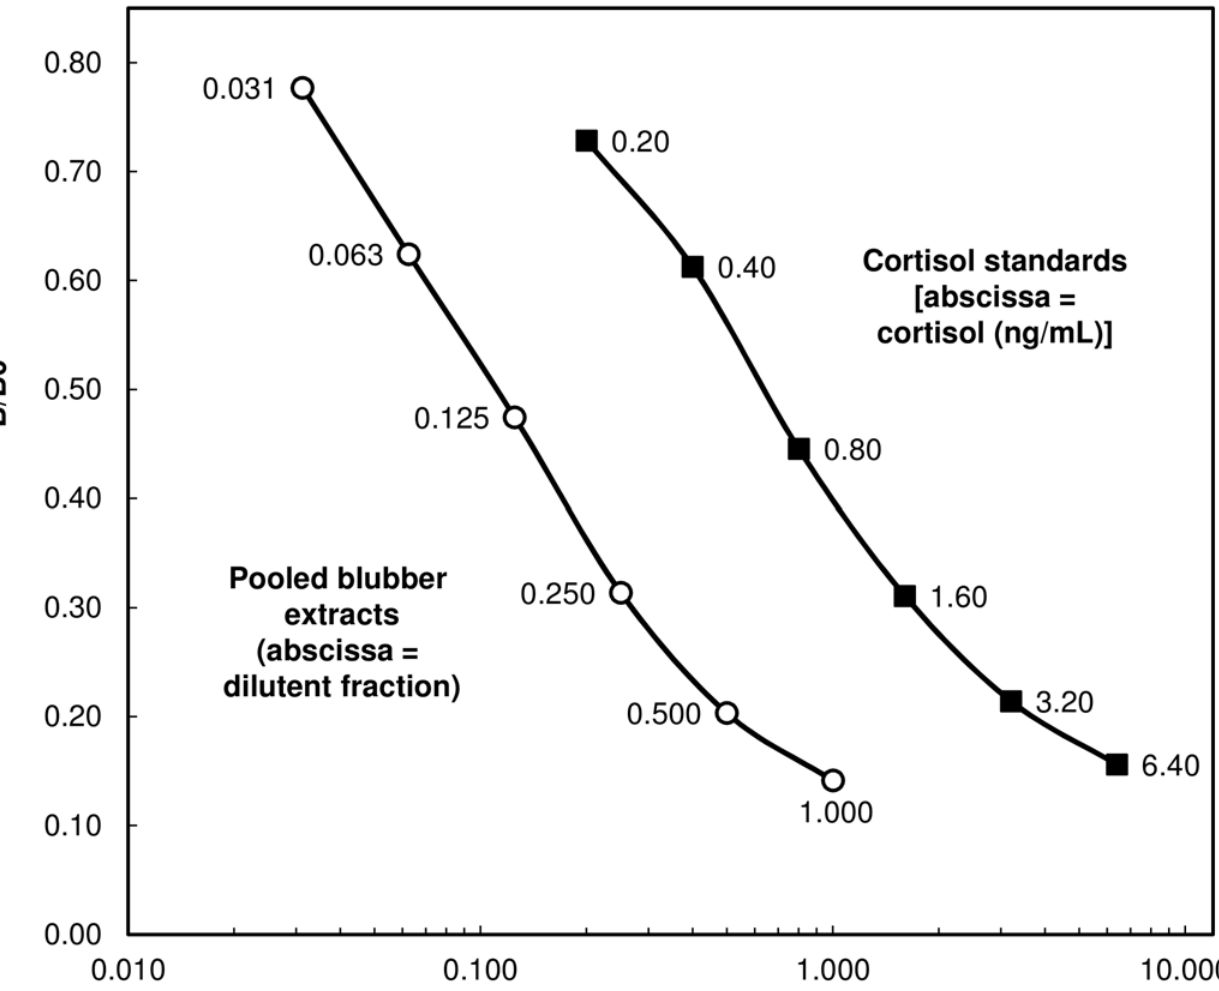
Fig 1. Results from linearity assessment of cortisol enzyme immunoassay (EIA) with blubber tissue extracts. Serial dilutions of extracts (open circles) show parallelism with the standards of the cortisol EIA (dark squares) (observed/expected = 1.01, 95%CI: 99.3 – 1.06); an indication that the assay is measuring the same antigens in the blubber as in the standards and therefore suitable for use with the short-beaked common dolphin blubber tissue extracts. Four individuals were represented in the pooled blubber extracts; 1 male and 3 female.